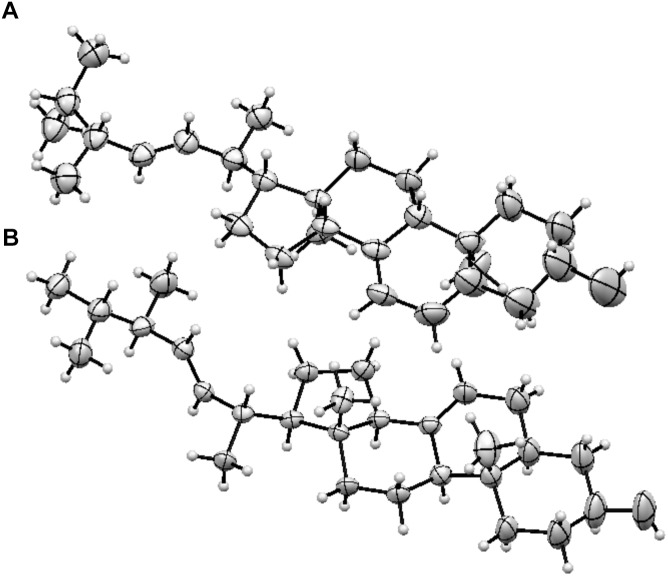
ORTEP structures (A) Ergosterol, (B) 5, 6-dihydroergosterol.